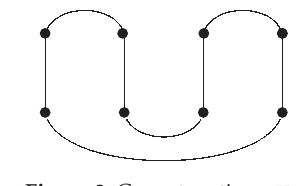
Figure 3: Concatenation a T b